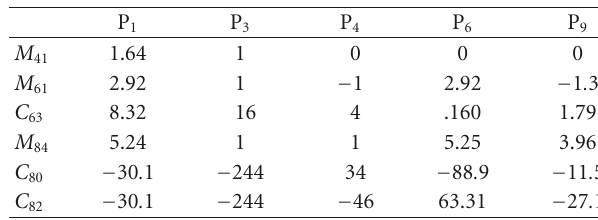
Table 1: Some of the features for a number of digital signal